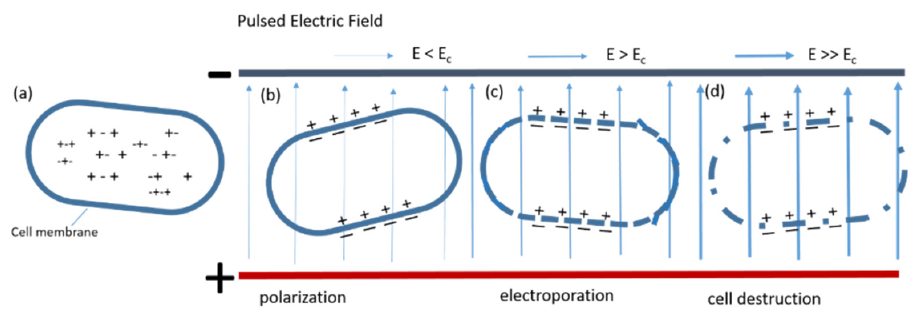
Figure 1. Mechanism of PEF action